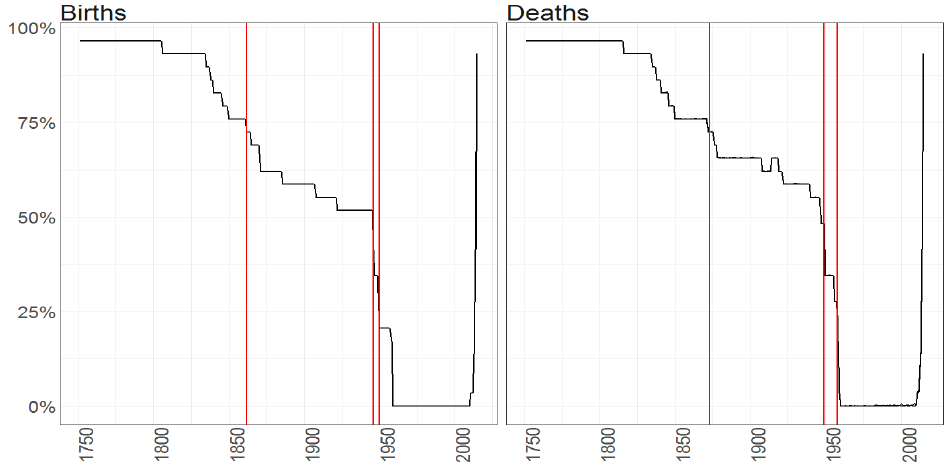
Figure 1. The percentage of missing entries (y axis) per observation vector over time (x axis) for the Births counts (left plot) and Deaths counts (right plot) for female (blue line) and male (blacke line) population. Red vertical lines correspond to the starting points in time of samples when maximum of missing entries is equal to (from the left side on corresponding plots) 75%, 50% and 25%.